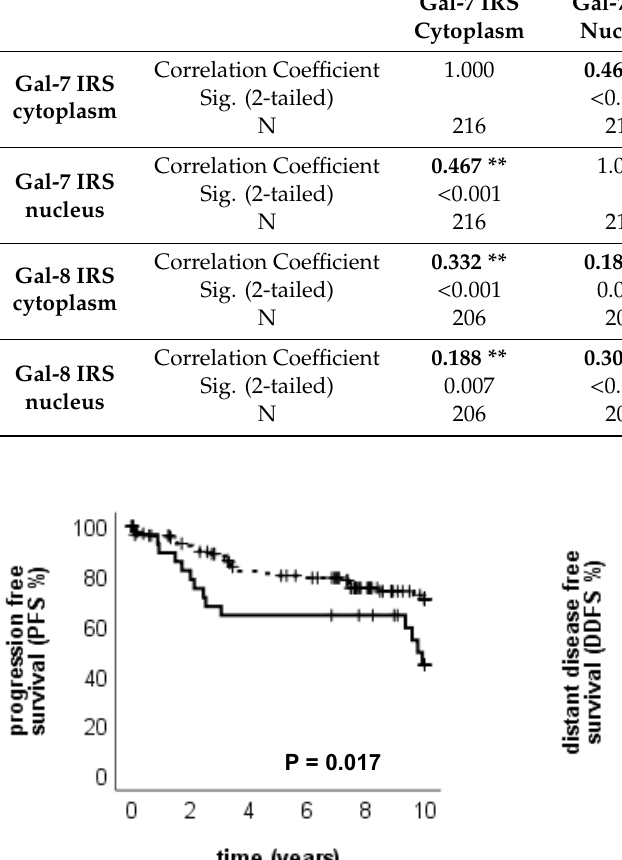
Table 3. Spearman correlation analysis of Gal-7 and Gal-8 expression in the nucleus and cytoplasm. Significant correlations are displayed in bold. ** indicates a significance level of p < 0.01.